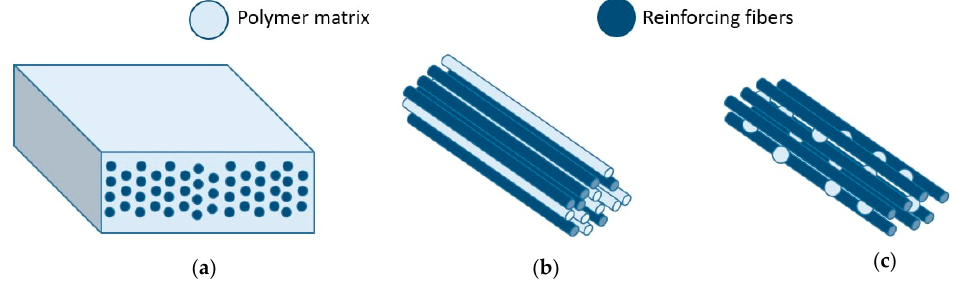
Figure 6. Prepregs schemes: ( a ) preconsolidated tapes, ( b ) commingled yarns, and ( c ) towpregs.